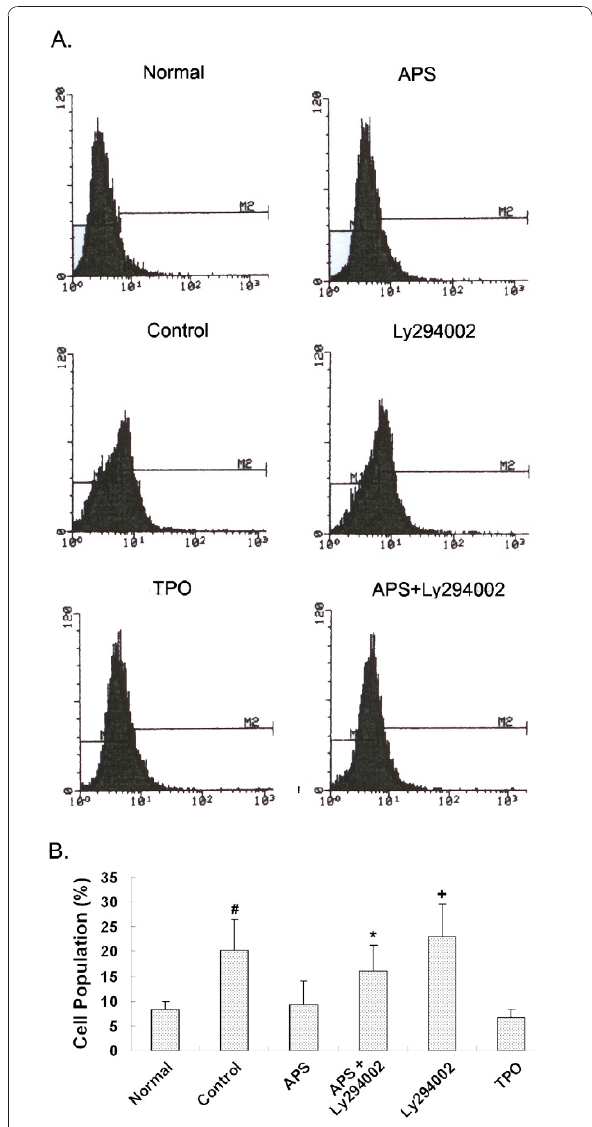
Figure 8 Effects of APS on apoptosis analyzed by Caspase 3 assay . M-07e cells were treated as described above, stained with Caspase 3-PE (FL-2) and subjected to flow cytometry analysis. (A). Histogram of Normal, APS-treated, Control, Ly294002-treated, TPO- treated and APS+Ly294002-treated samples. (B). Quantification and statistical analyses of treatment effects. Statistical tests were carried out between the control/treated samples and the corresponding normal samples respectively. *: p < 0.05; #: p < 0.01 and +: p < 0.001.